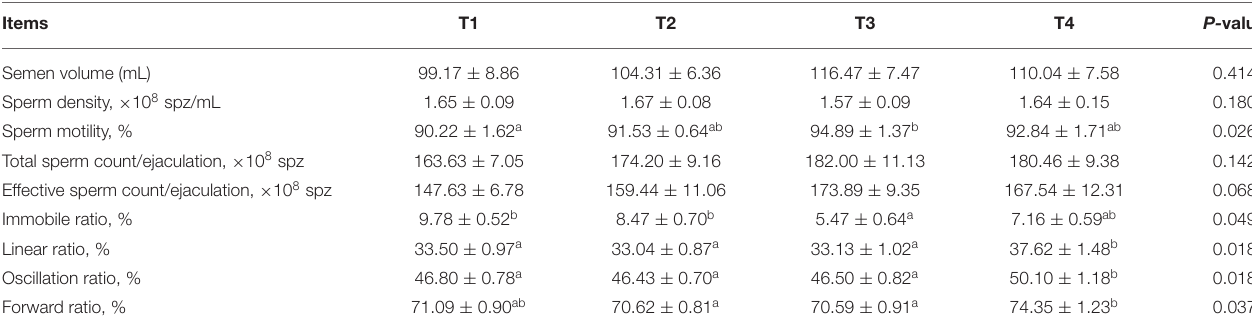
TABLE 6 | Effect of dietary fiber and metabolites on semen quality of boars (1–8 weeks).